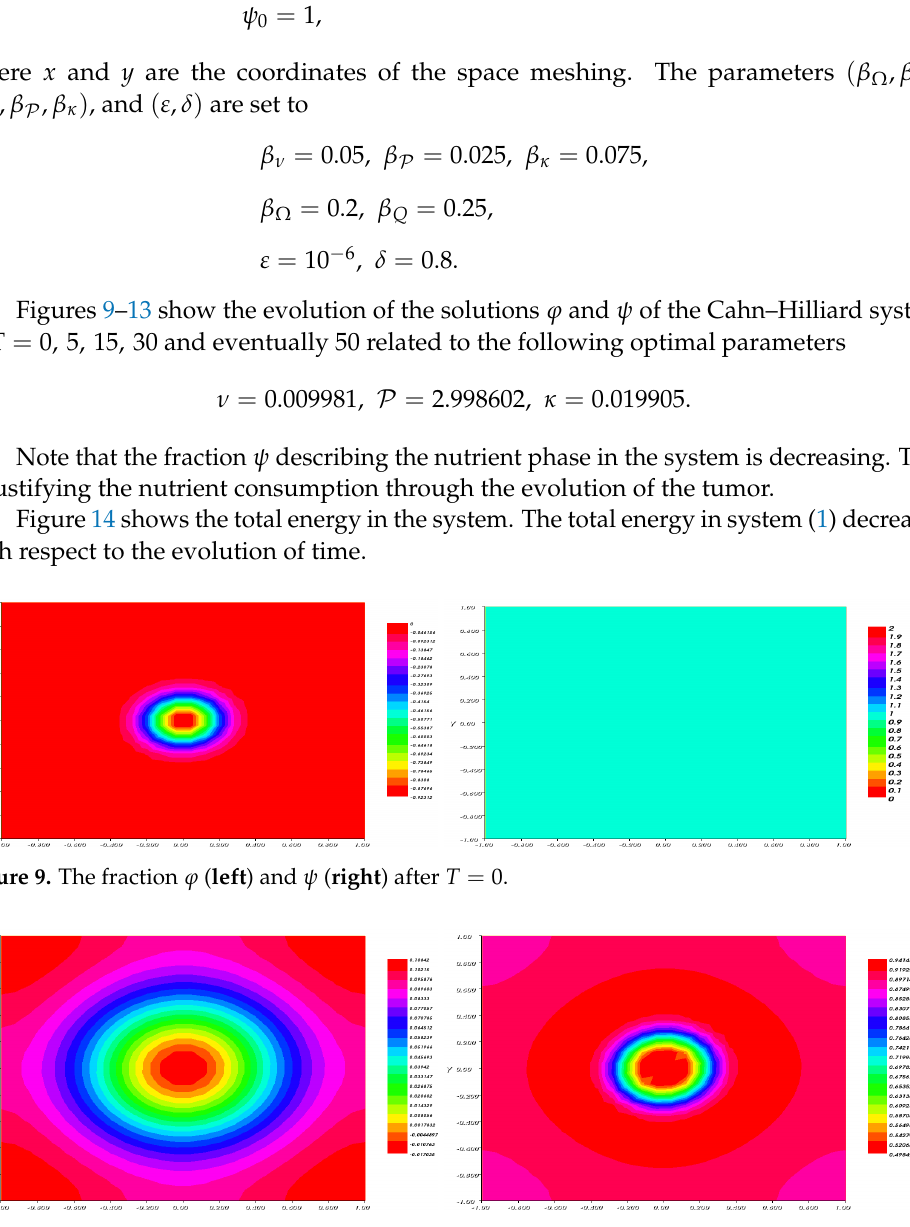
Figure 10. The fraction ϕ ( left ) and ψ ( right ) after T =